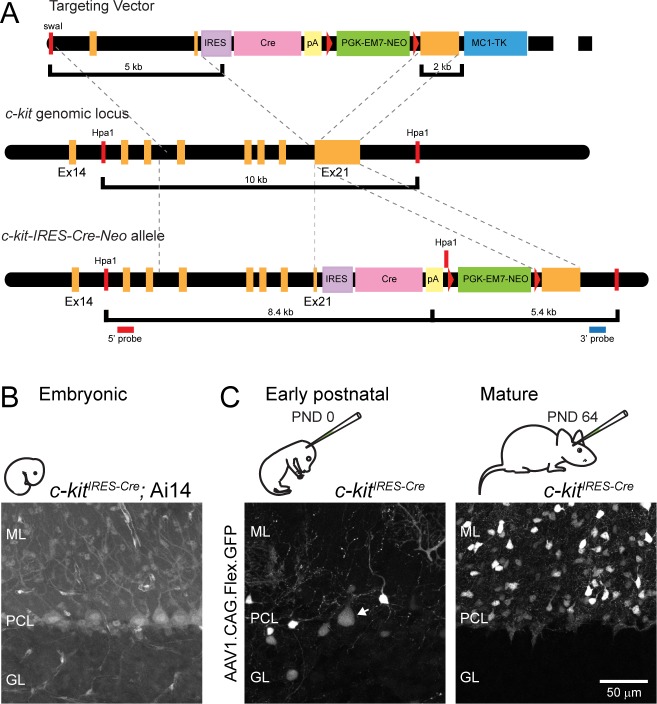
c-kitIRES-Cre mice allow for MLI targeting in mature mice.(A) Schematic of c-kitIRES-Cre mouse generation. ML, molecular layer; PCL, Purkinje cell layer; GL, granule cell layer. (B) Reporter protein expression in a c-kitIRES-Cre:Ai14 (lox-P flanked, Rosa26-tdTomato) mouse perfused at PND 38. This cross will report the entire history of Cre recombinase activity including during embryogenesis. (C) The cerebella from c-kitIRES-Cre mice injected with Cre-reporter virus at PND 0 or PND 64. Tissue was prepared from animals 27 and 14 days after injection, respectively. Arrow points to a labeled PC in PND 0-injected cerebellum. Note the absence of Cre activity in PCs in mature animals. Scale bar in lower right applies to all images.